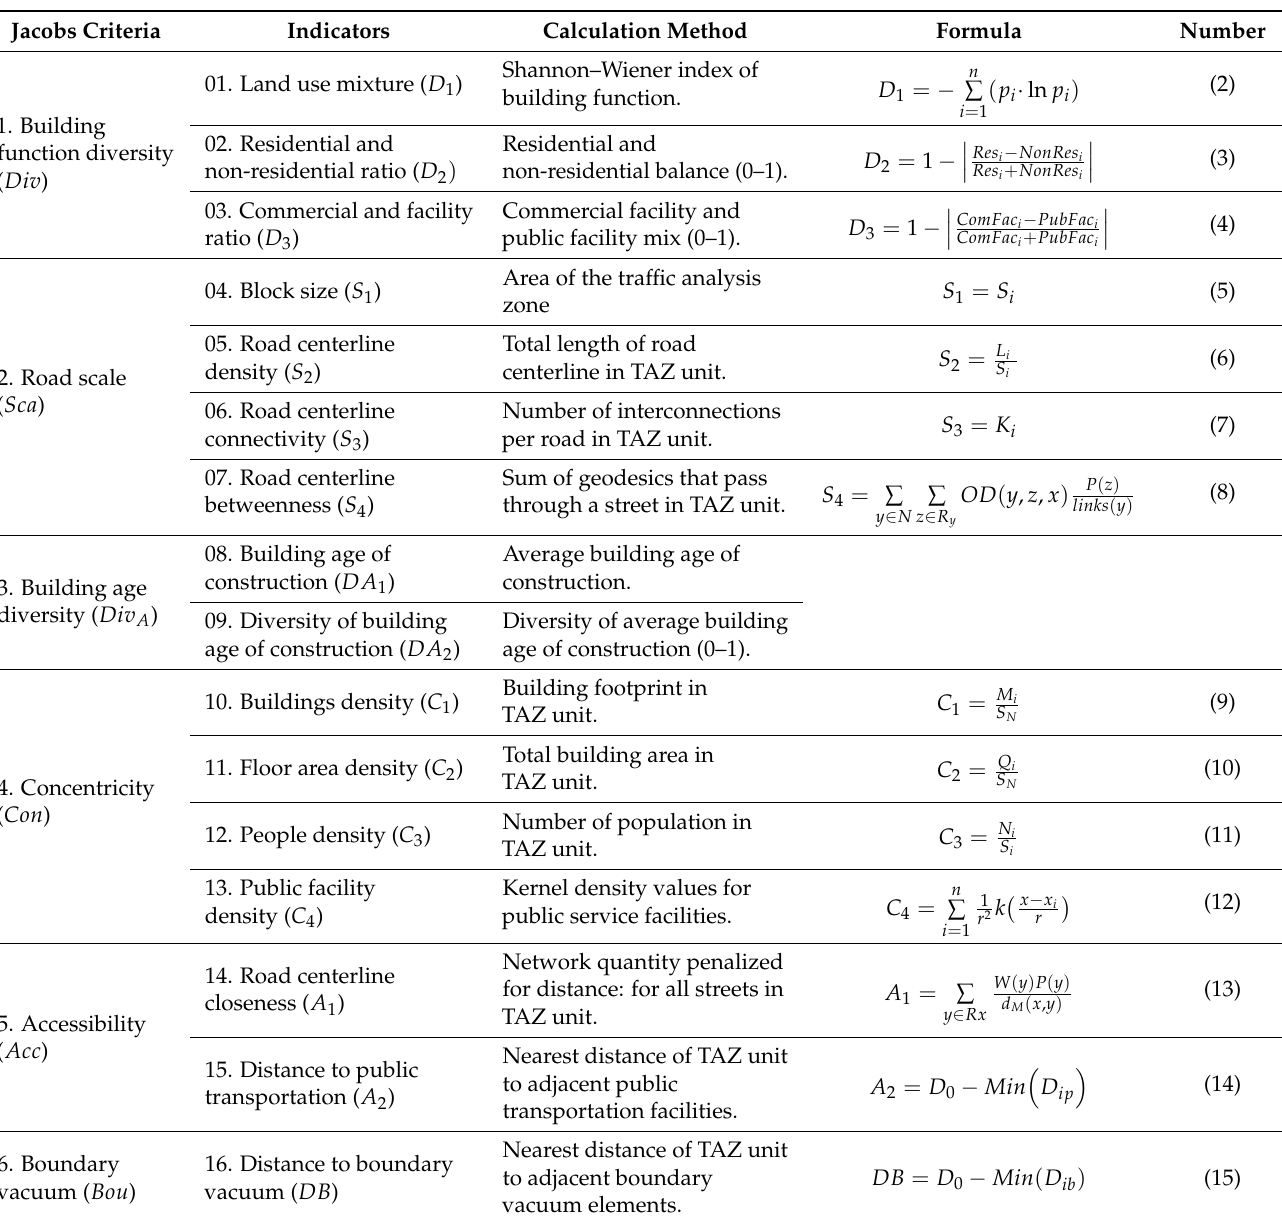
Table 1. Conditions and indicators that were used in the